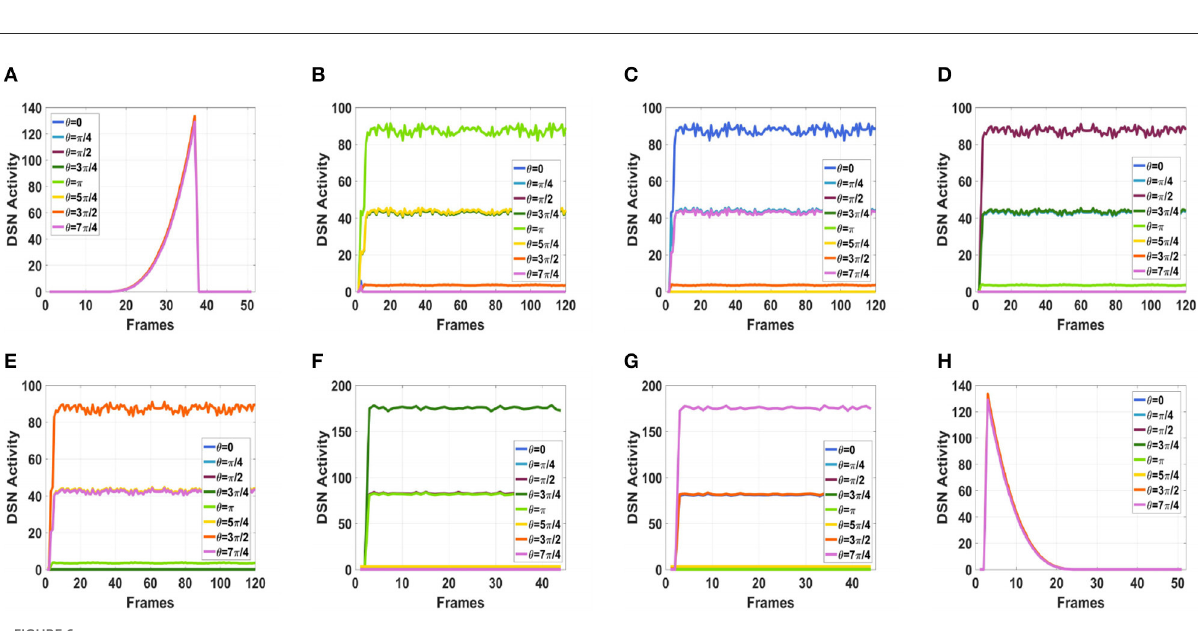
FIGURE6 Simulation results for the directionally selective fractional-order LGMD collision sensing visual neural network. (A) Object looming motion, (B) object translating leftwards, (C) object translating rightwards, (D) object translating upwards, (E) object translating upwards, (F) object left upper corner motion, (G) object right lower corner motion, and (H) object faraway